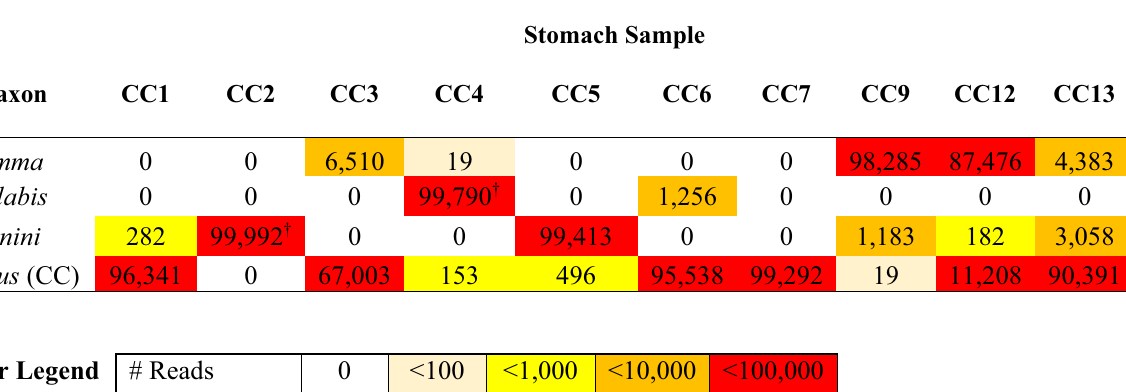
Table 3. Heatmap of prey identified in the stomachs of Cookiecutter sharks (CC) via eDNA metabarcoding of gastric fluid contents. Data for a given stomach sample (e.g. CC1 is Cookiecutter shark one) is presented as the mean read count from the rarefied dataset. Note that while there was not sufficient DNA for metabarcoding of CC11, a tissue sample from this stomach was Sanger sequenced and identified as Thunnini. † Confirmed by Sanger sequencing of tissue